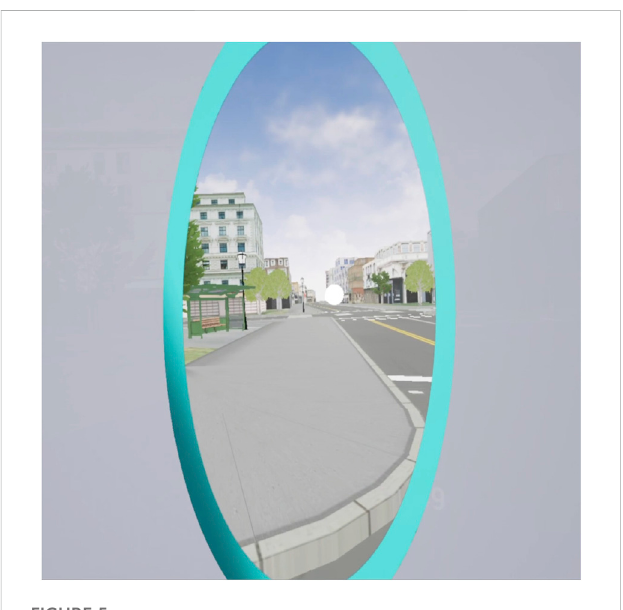
FIGURE 5 A screenshot of the implemented Portal Preview